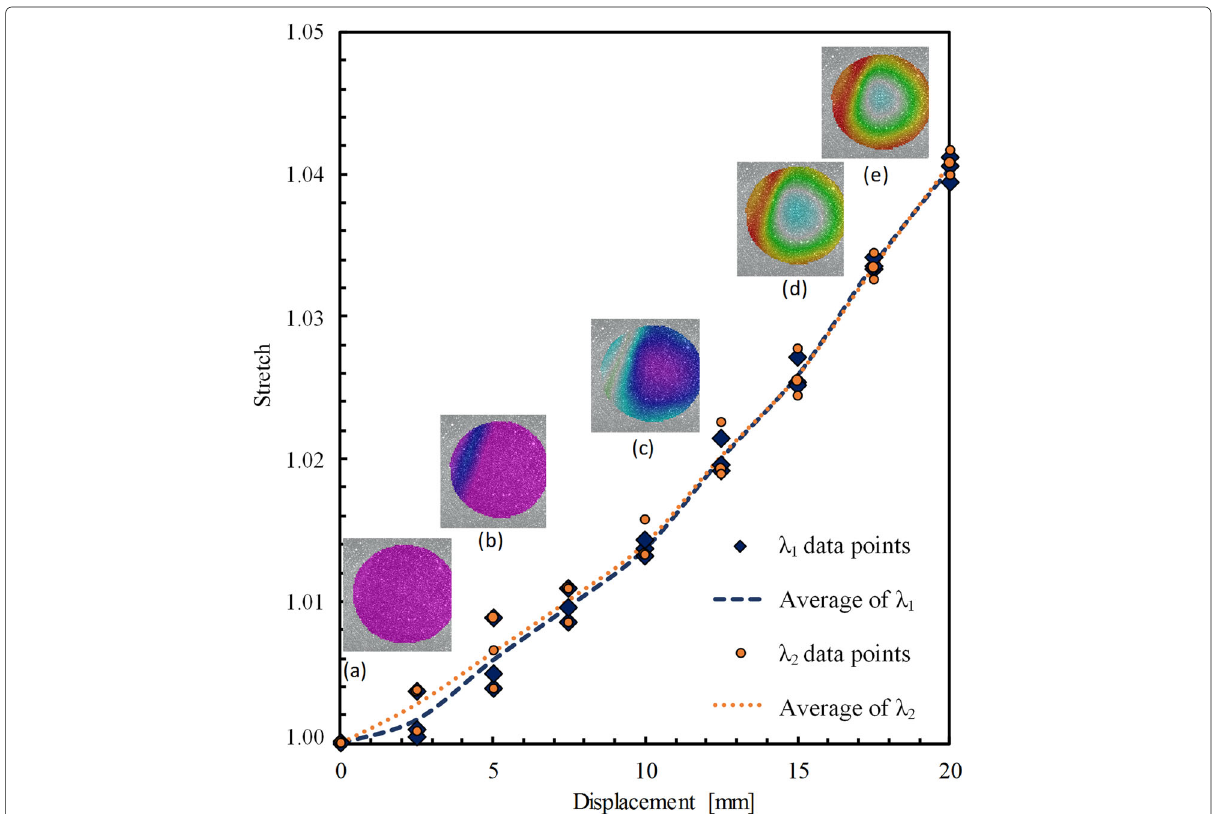
Fig. 12 In-plane stretches plotted against the displacement of the flange fixture for the rubber membrane stretched over a 160-mm pipe, together with images of the displacement field at a 0 mm displacement, b 5 mm displacement, c 10 mm displacement, d 15 mm displacement and e 17.5 mm displacement of the flange